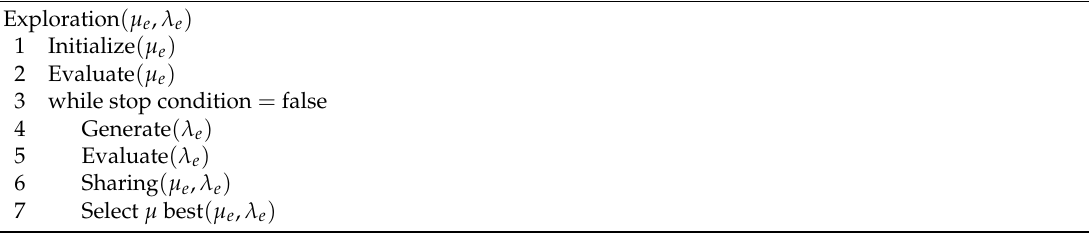
Algorithm 2 Pseudocode for the exploration phase of HSA